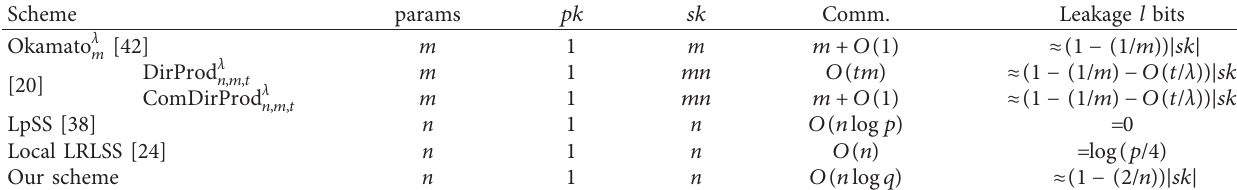
Table 4: Comparison of our scheme with other schemes.